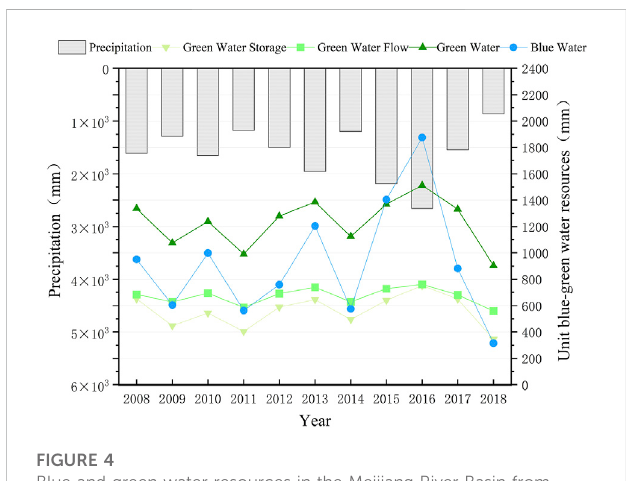
FIGURE 4 Blue and green water resources in the Meijiang River Basin from 2008 to 2018.